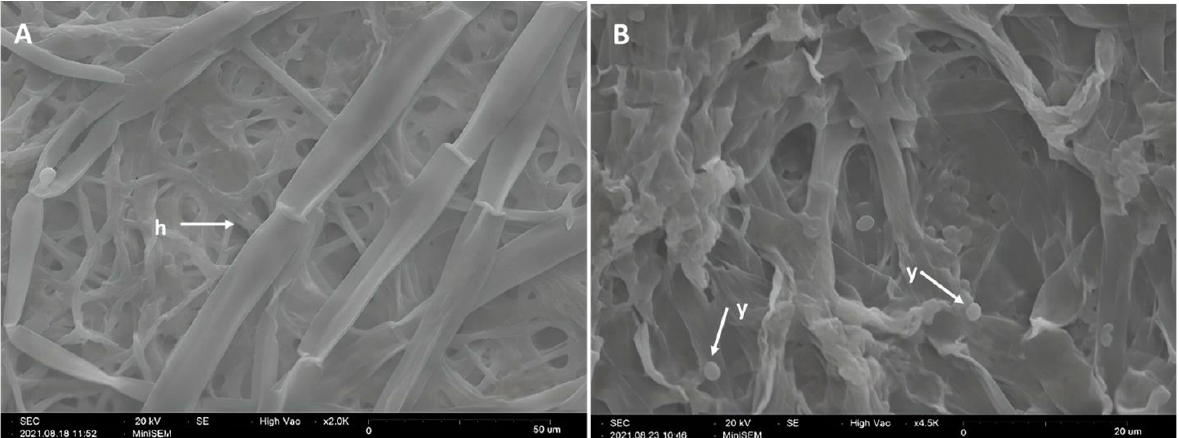
Figure 3. Effect of Debaryomyces hansenii on the structures of B. cinerea . ( A ) hyphae (h) of B. cinerea without treatment. ( B ) L1 cells of Debaryomyces hansenii (y) on hyphae of B. cinerea .